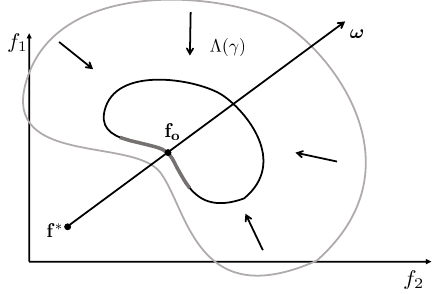
Figure 2. Geometrical representation of the goal attainment